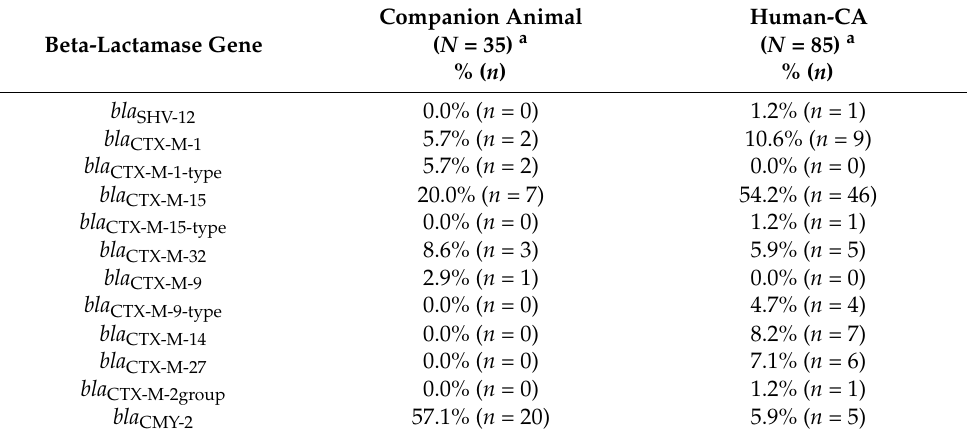
Table 4. ESBLs and p AmpC genes in 3GC-ressistant E. coli isolated from companion animals